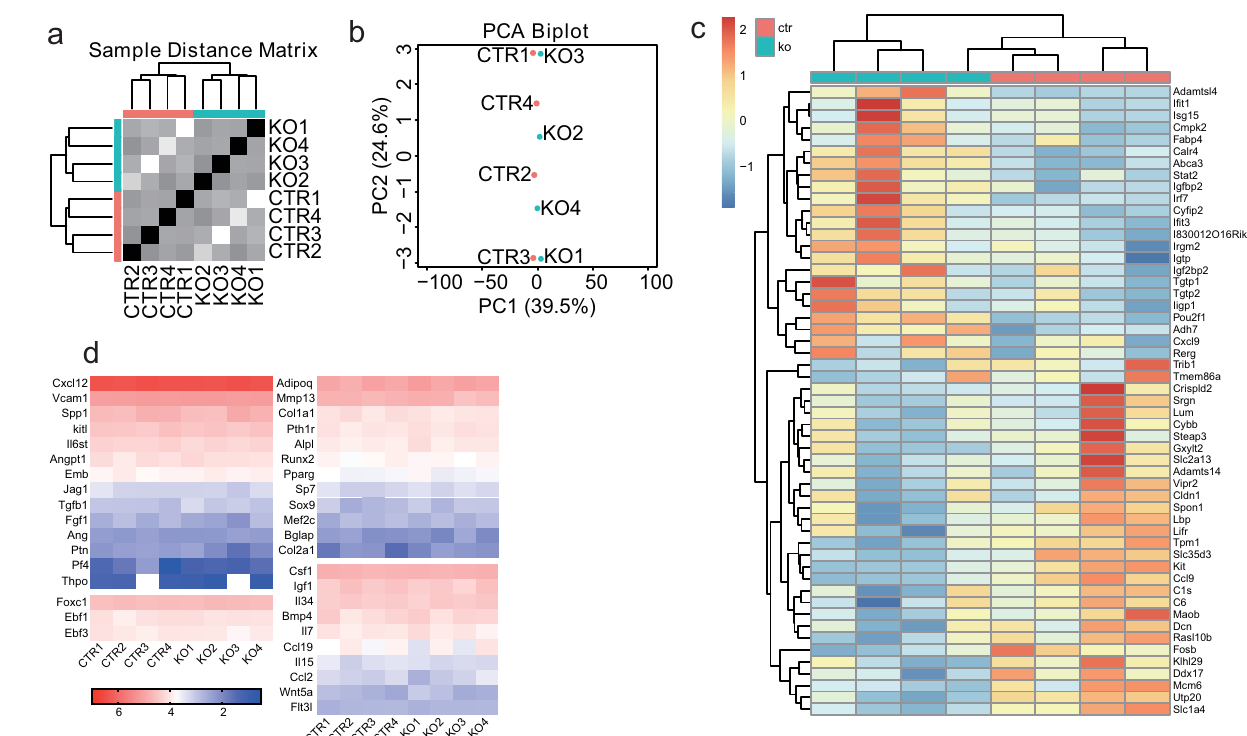
c Differentially expressed genes in MSPCs isolated from Flk2-cre.Cxcr4 fl /+ (red) and Flk2-cre.Cxcr4 fl / fl (blue)mice.PlottedgenesshowednormalizedRNAcounts>0inall samples, FDR adjust p <0.05. d Heatmap representation of log10 normalized RNA counts of genes important for HSC maintenance and multilineage differentiation. All panels are derived from n =4 mice per